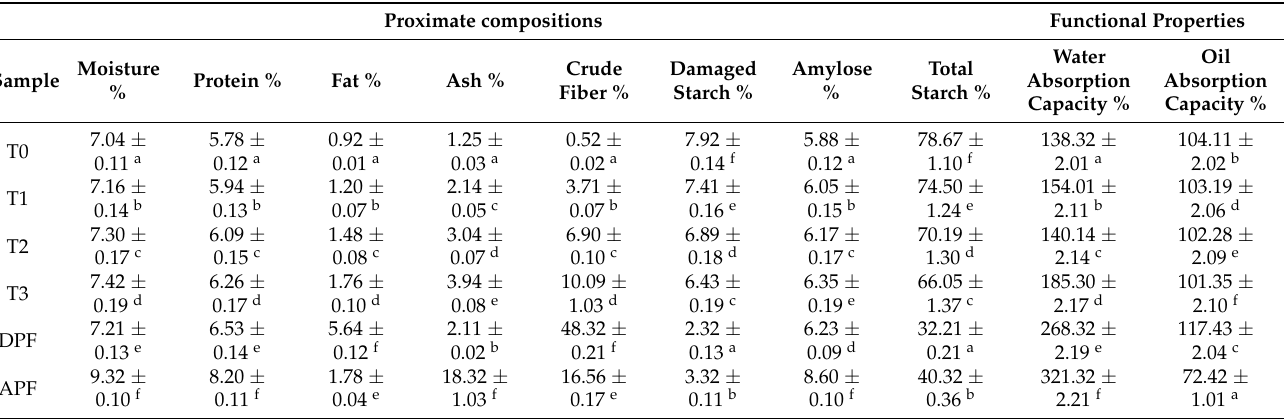
Table 2. Proximate compositions and functional properties of rice flour (RF), date pit flour (DPF), Assyrian plum flour (APF), and their flour blends. Proximate compositions Functional